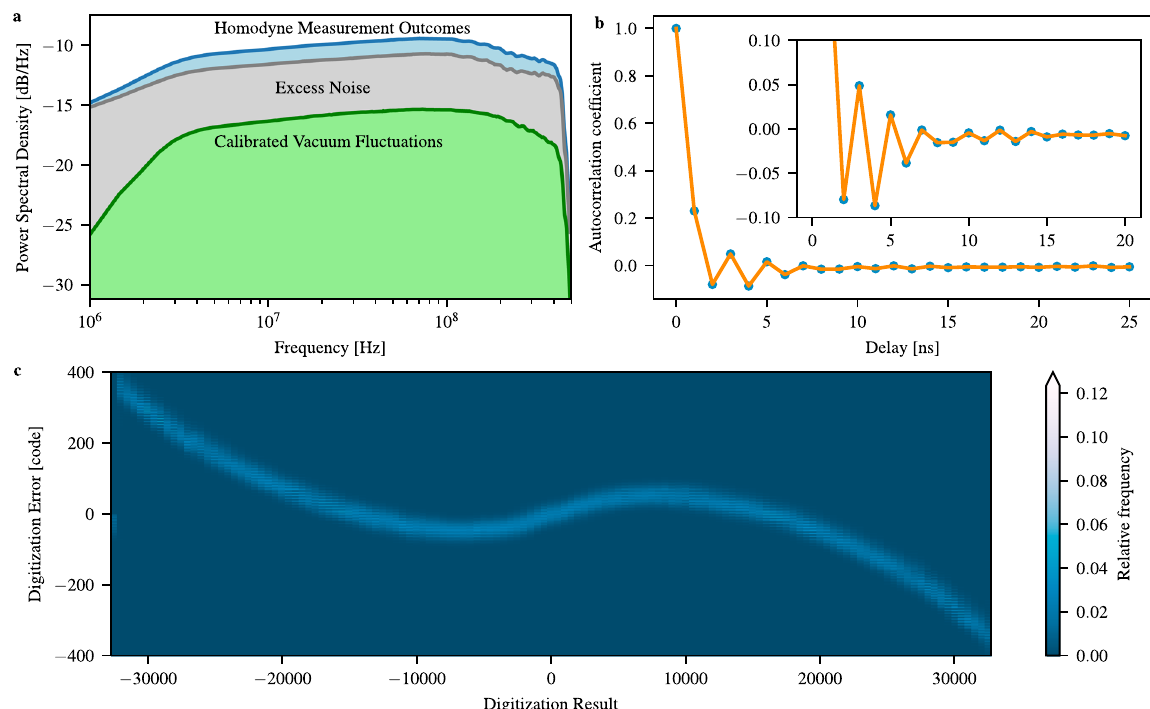
Fig. 4 Experimental results. a The fi gure shows the power spectral densities (PSDs) of the measurement outcomes, the calibrated vacuum fl uctuations (obtained by the system characterization), and the excess noise (obtained by subtracting the PSD of the vacuum fl uctuations from the PSD of the measurement outcomes). b Autocorrelation coef fi cients calculated from the measured samples and averaged 1000 times. The inset shows a zoom. c Relative frequency of the digitization error of the analog-to-digital converter (ADC) with respect to the digitization results. The non-linearity and digitization noise of the ADC leads to a large reduction of the